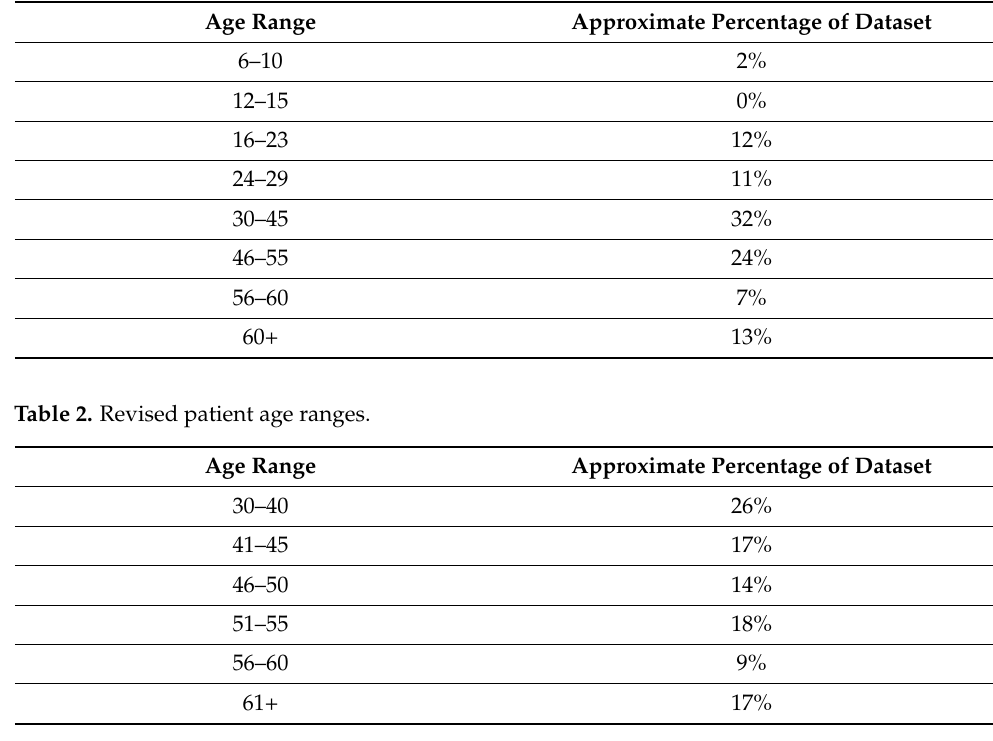
Table 1. Initial patient age ranges.